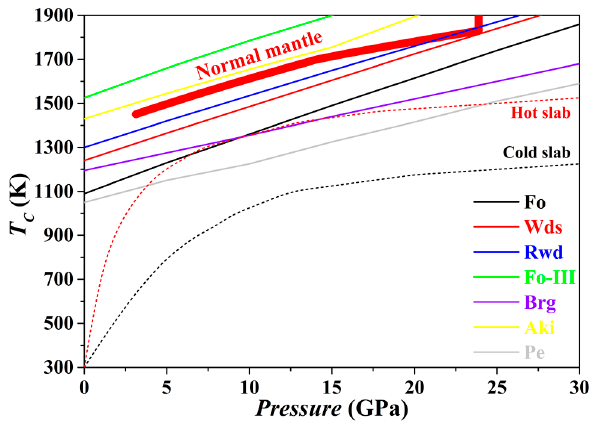
Figure 13. Calculated characteristic temperatures ( T C ) for Fo, Wds, Rwd, Aki, Brg, Pe and Fo-III from 0 to 30 GPa. The P - T profile of the cold slab or hot slab is sketched according to Thompson [93], while that of the normal mantle is from Anderson [94].